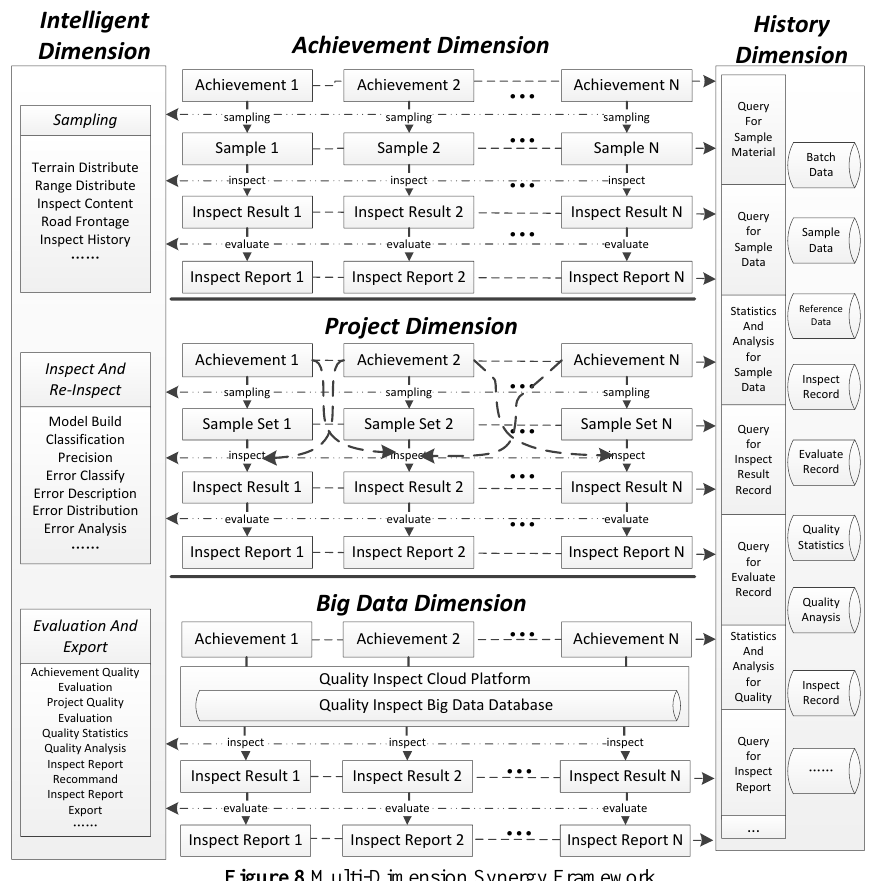
Figure 8 Multi-Dimension Synergy